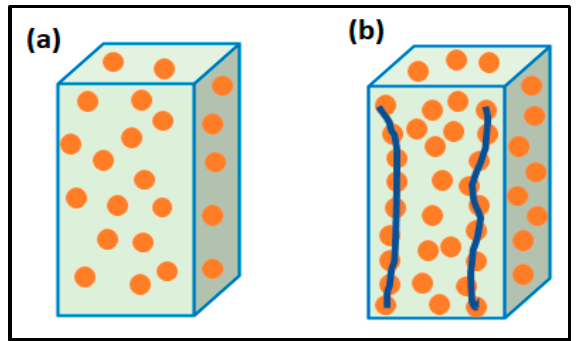
Figure 2. ( a ) Schematic diagram at inadequate fillers loading; ( b ) Formation of the thermal pathways at adequate fillers loading.